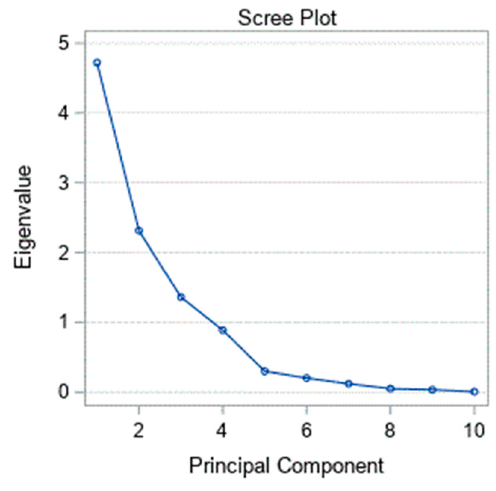
Figure 2. Scree plot for the principal components. Table 2. Correlations between the handgrip strength measurements.